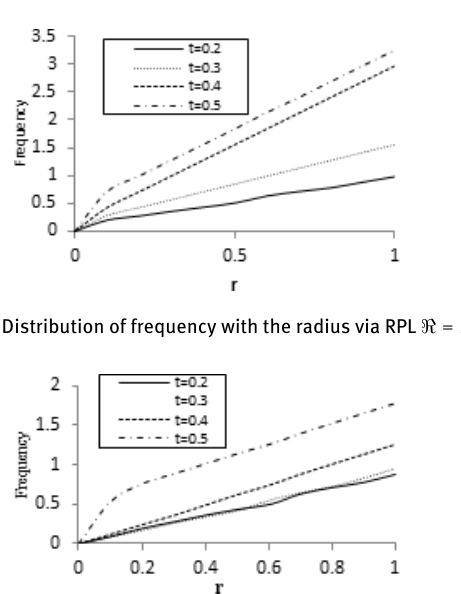
against the radius of rod for different values of parameter t in RPL model is detected in Figures 10 and 11. The frequency distribution is follows growing nature for increasing values of radius of rod for different values of parameter t in both RPL ( ℜ = 2 and ℜ = 4) models. The temperature distribu- tion creates sensible consideration for increasing value of ℜ in RPL model.